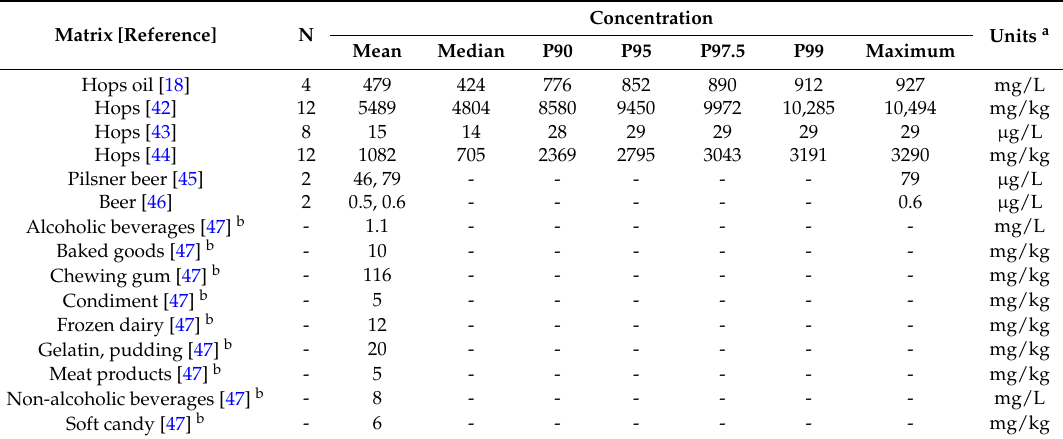
Figure 1. NMR spectra of an authentic coffee sample ( blue line ) containing 408 mg/kg of furfuryl alcohol compared to the reference standard ( red line ). Table 2. β‐ Myrcene content in various matrices.